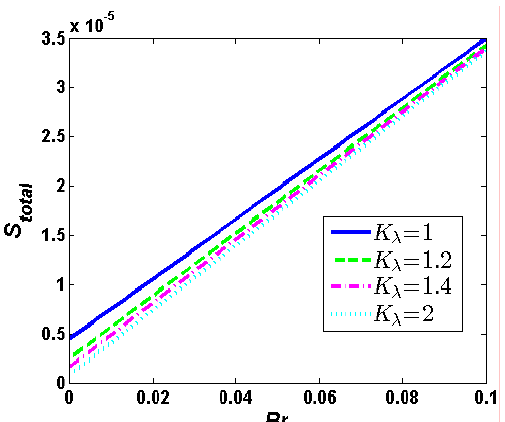
Figure 7. Distribution of total entropy generation when λ = 0.25, d = 0.15, R = 1, α = 1, u r = 1, J = 5, Θ = 1000.